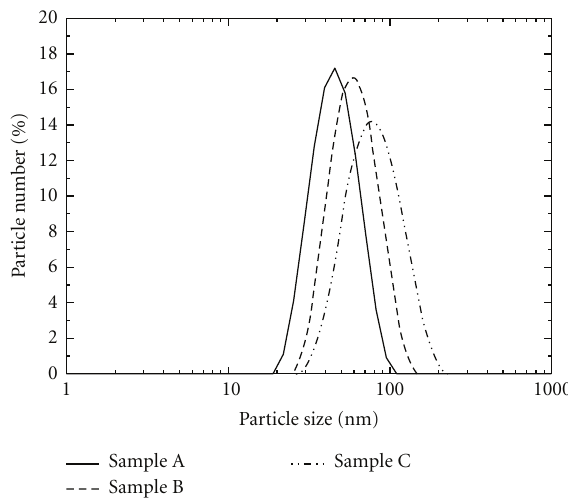
Figure 3: Particle size distribution of the TiO 2